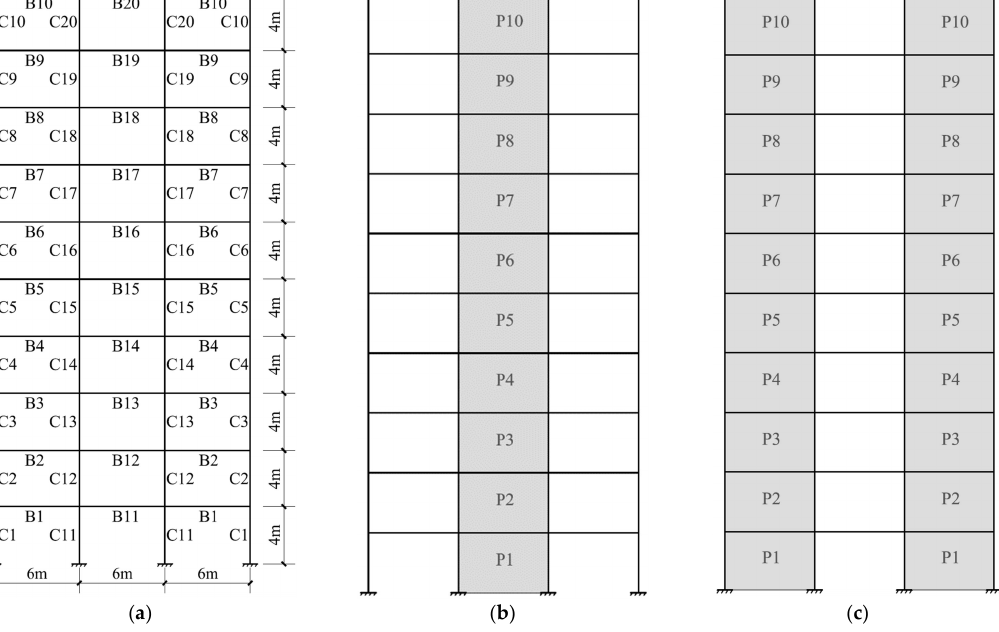
Figure 5. Ten-story steel frame: ( a ) element group numbers; ( b ) SPSW1-10; and ( c ) SPSW2-10.